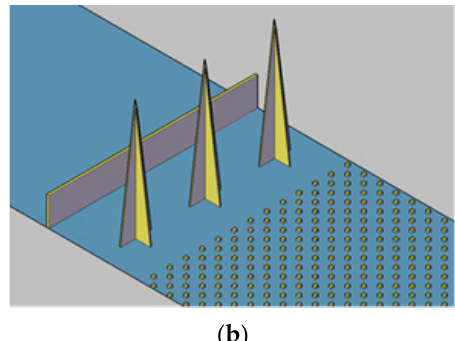
Figure 3. ( a ) Wind tunnel at the School of Engineering of the Universidad de “la República” Uru- guay; ( b ) the Standen Method for the establishment of the vertical wind profile according to rough- ness length and mean wind speed.